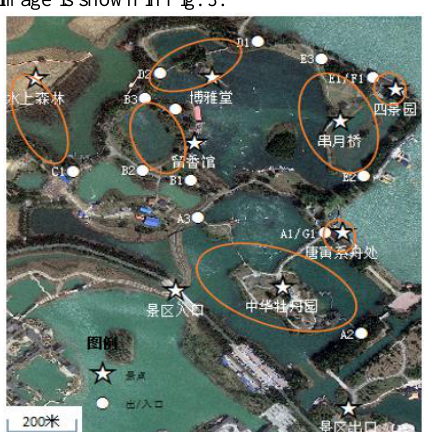
Fig. 3 Remote-sensing Image of Experiment